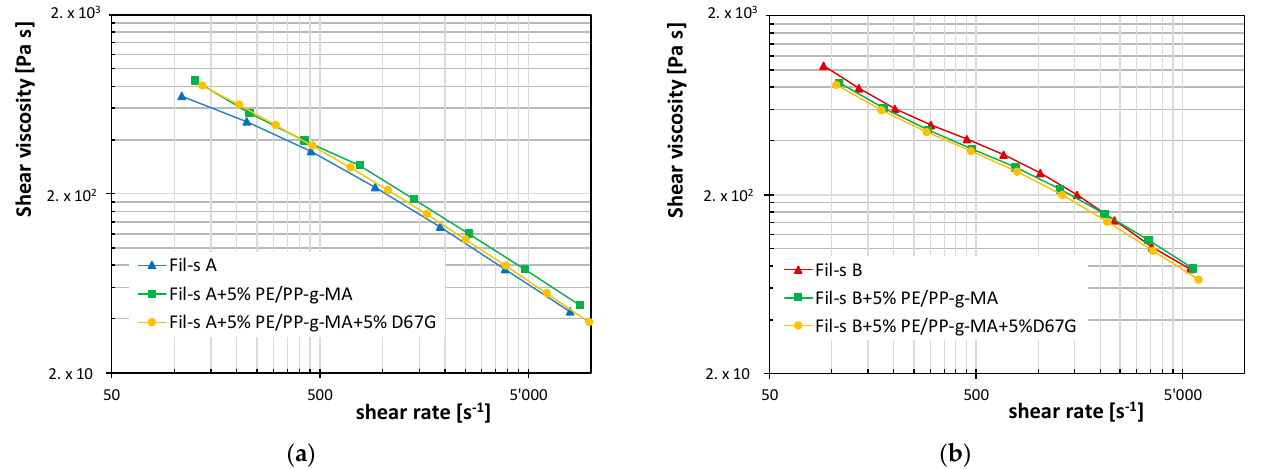
Figure 7. Shear viscosity vs. shear rate plots for ( a ) Fil-s A-based systems and ( b ) Fil-s B-based systems. The solid lines do not represent model fittings, but they are reported to help data visualization.